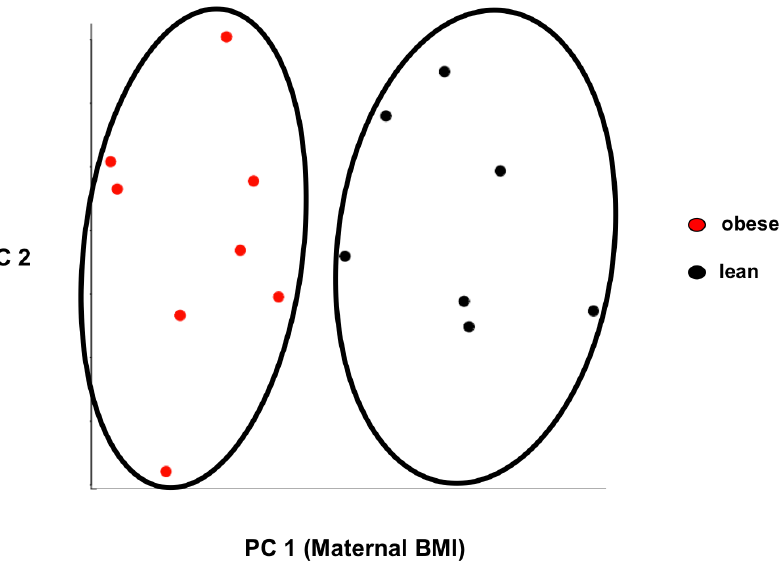
Figure 3. Principal Component Analysis of Genes Implicated in Central Nervous System Apoptosis. Figure demonstrates the results of the principal component analysis. Obese subjects are represented by red spheres and lean subjects are represented by black spheres. The results suggest that gene expression segregates on the basis of maternal BMI. On the x-axis is principal component (PC) 1, maternal body mass index (BMI), which accounts for the greatest proportion of variance in the gene expression data (21%). On the y-axis is PC 2, which accounts for the second